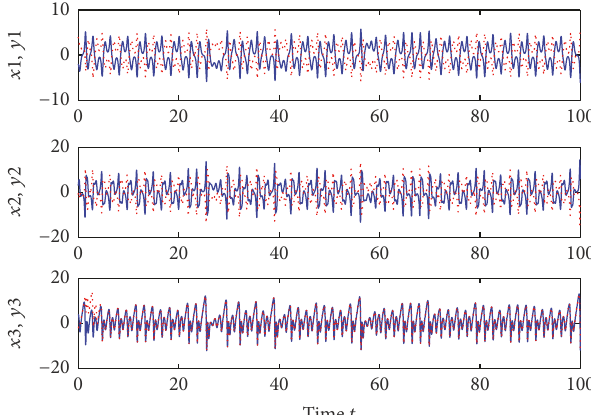
Figure5:Thisfiguresshowsthat 𝑥 1 , 𝑥 2 antisynchronize 𝑦 1 , 𝑦 2 ,while 𝑥 𝑦 3 synchronizes 3 , respectively.